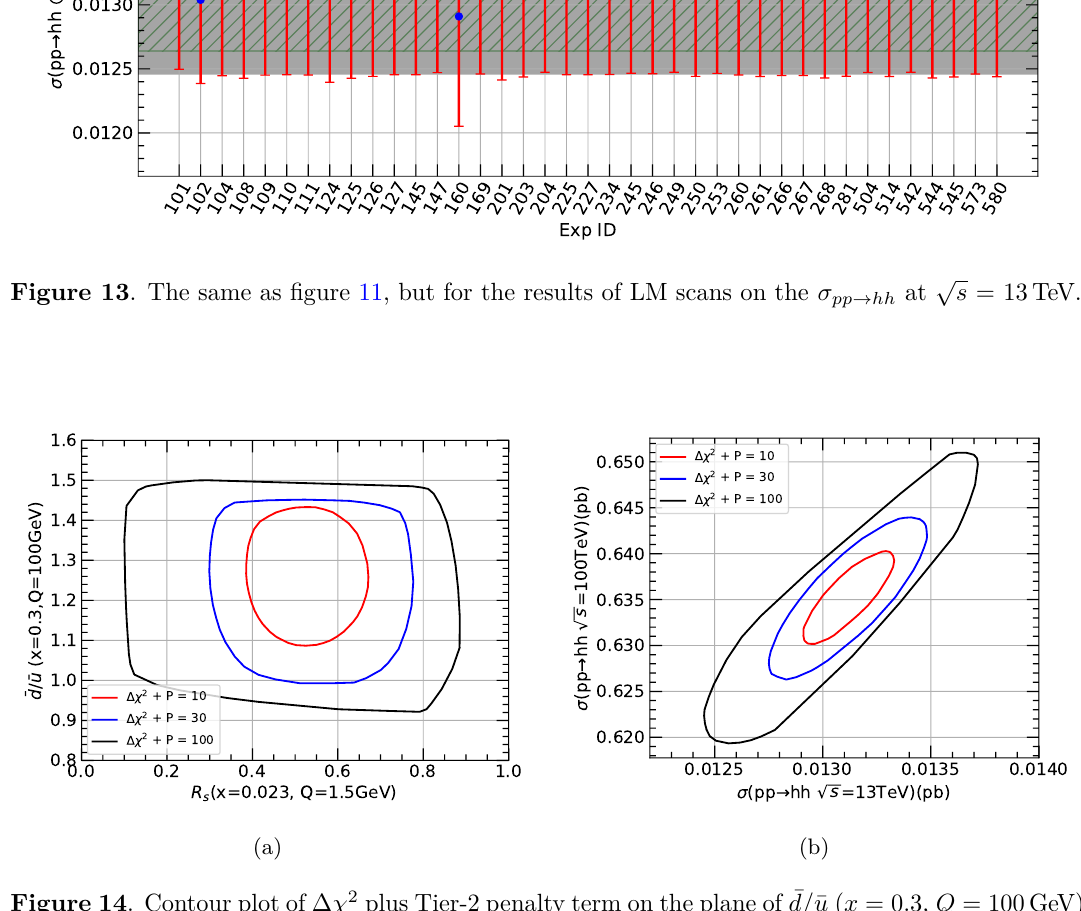
√ ( s = 13 TeV) vs. σ pp → hh ( pp → hh